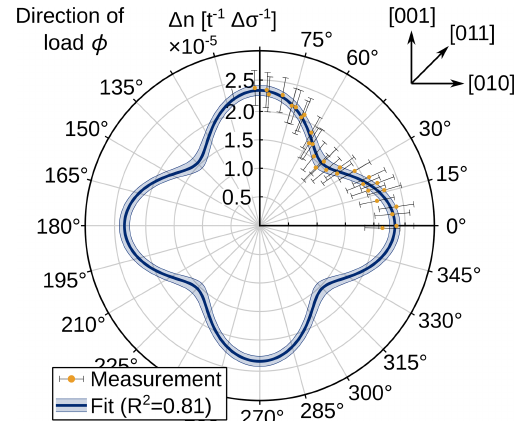
Figure 8. Stress-optical law for a {100}-silicon wafer with 95% confidence level (blue band), and the angle-dependent stress-optical coefficients C ( φ ) with a 95% confidence level (yellow). Stress- optical coefficients are displayed neglecting shear